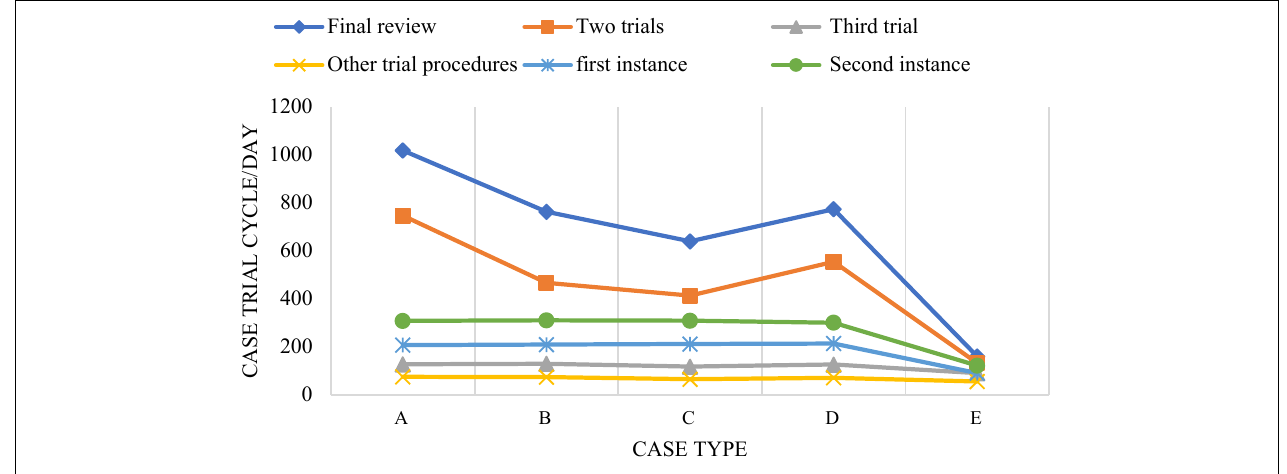
FIGURE 14 | The trial period of different types of cases under normal circumstances. (A: Traffic accident; B: copyright infringement; C: trademark infringement; D: copyright protection; E: theft infringement).